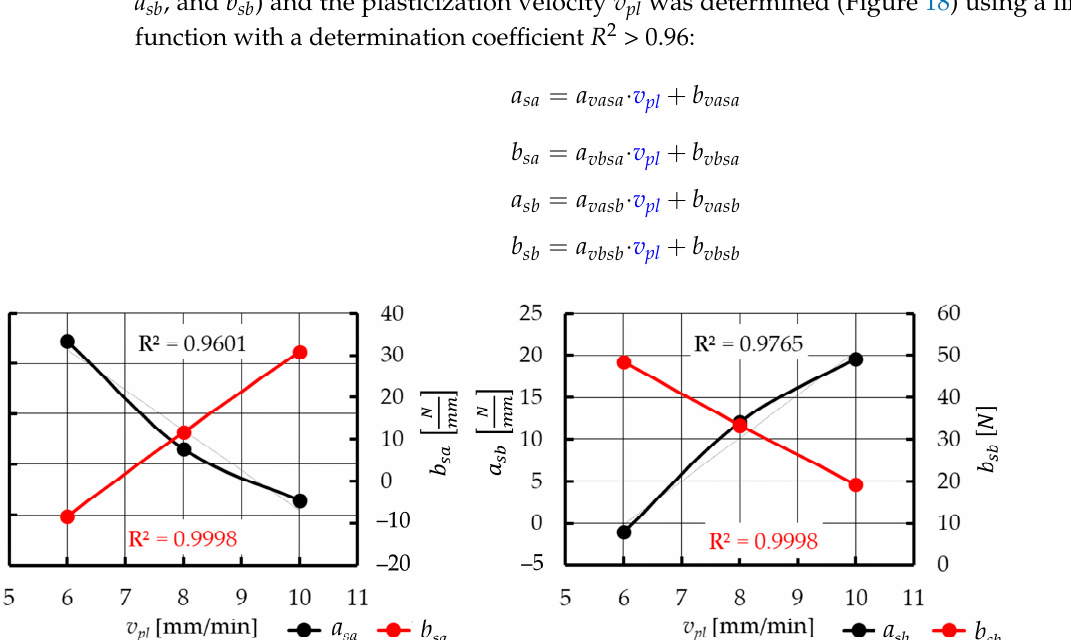
Figure 18. Exemplary correlation between the a sa , b sa , a sb , and b sb coefficients and the plasticization velocity v pl for the belt with 12 mm diameter, plasticized by the hot plate heated to temperature T p = 285 °C.